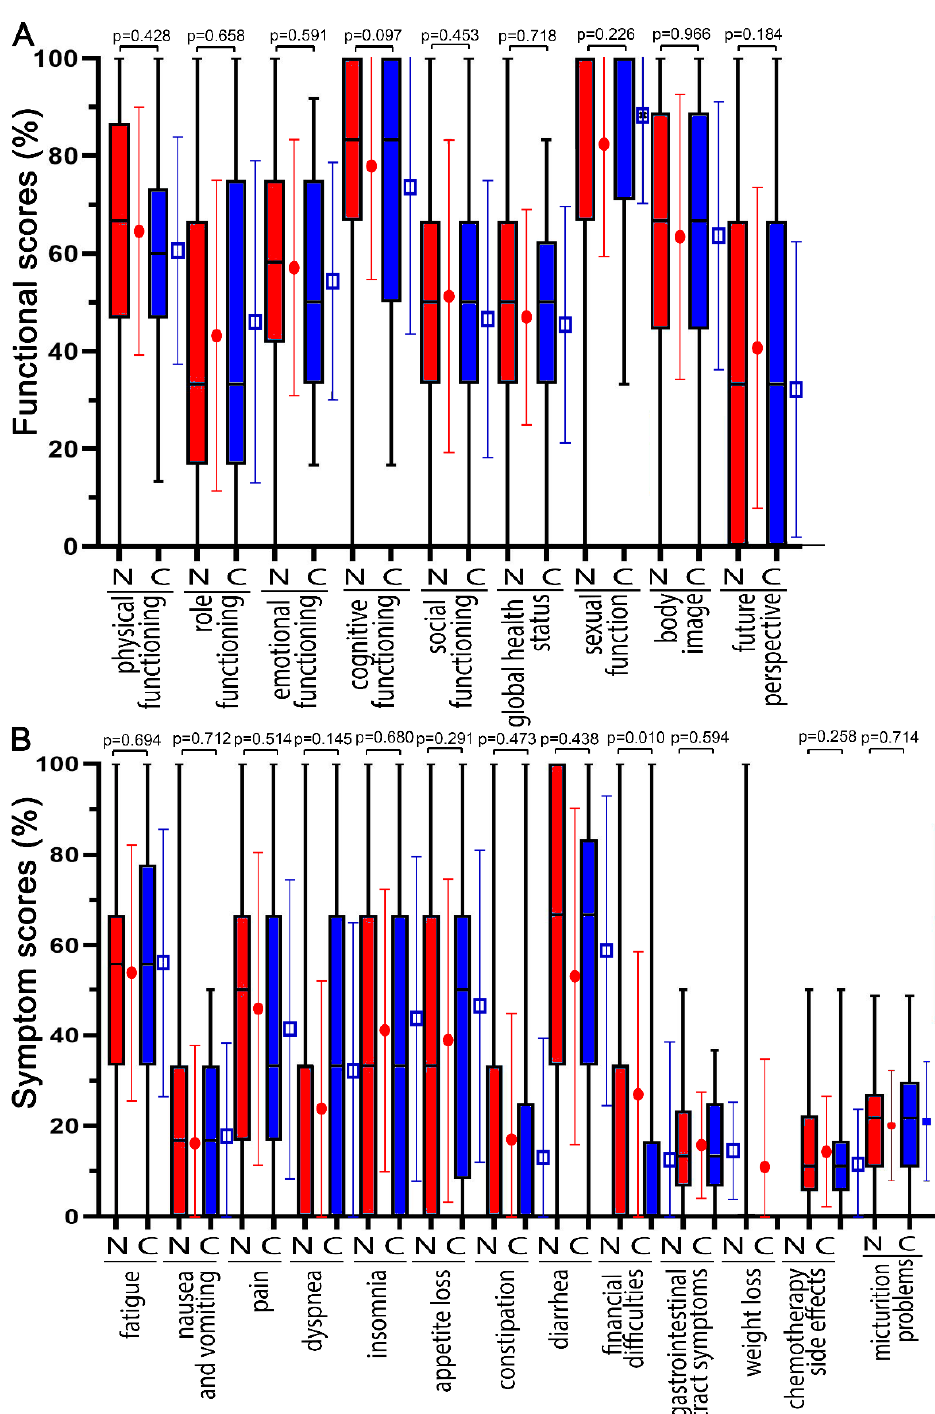
Figure 3 . The functional and symptom score distribution of prior to COVID-19 pandemic (N = non COVID) compared with during COVID-19 pandemic (C = during COVID pandemic). Scores were surveyed on day 14 (2 weeks) during radiochemotherapy. ( A ) Functional scores are: physical functioning, role functioning, emotional functioning, cognitive functioning, social functioning, global health status, sexual function, body image, and future perspective. ( B ) Symptom scores are: fatigue, nausea and vomiting, pain, dyspnea, insomnia, appetite loss, constipation, diarrhea, financial difficulties, gastrointestinal tract symptoms, weight loss, chemotherapy side effects, and micturition problems. □ and ● indicate the mean and error bars the standard deviation.